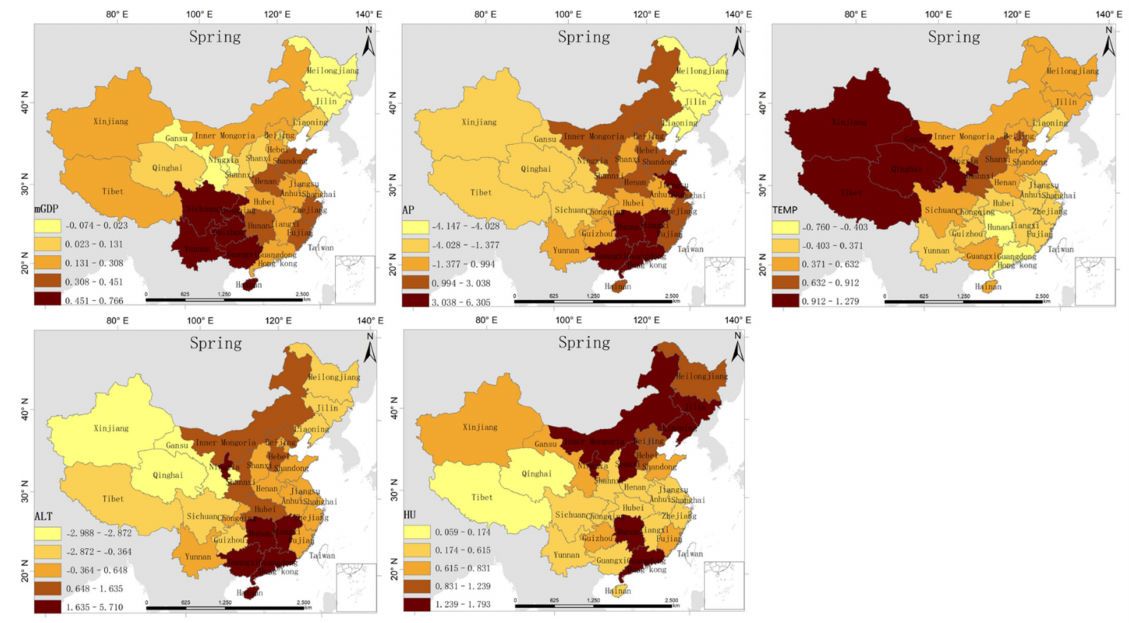
Figure 4. The spatial variations of the coefficients of the GWR model in spring.